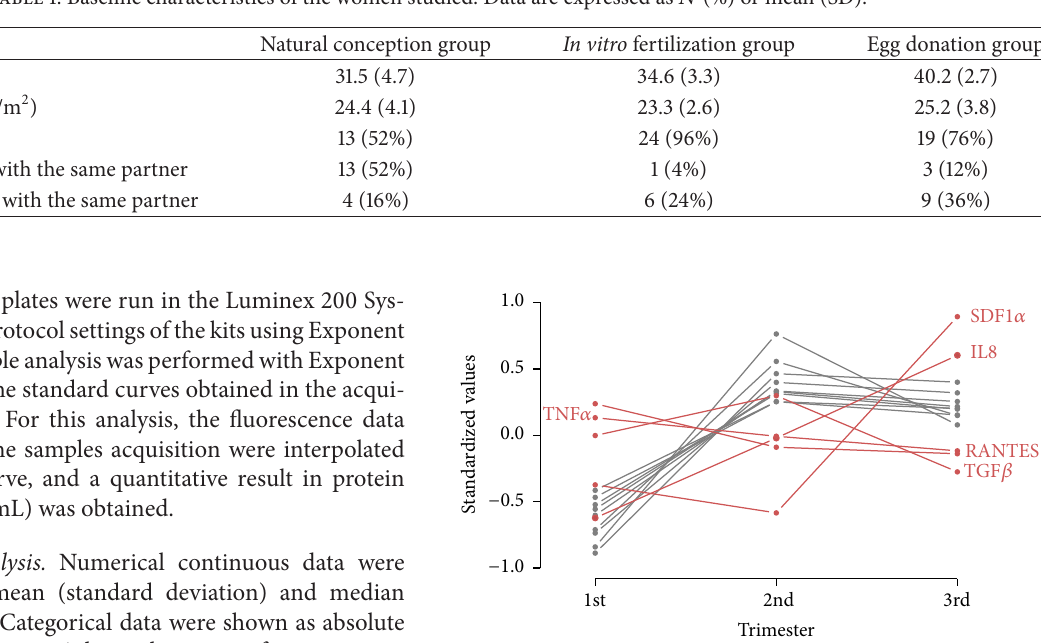
Table 1: Baseline characteristics of the women studied. Data are expressed as 𝑁 (%) or mean (SD).